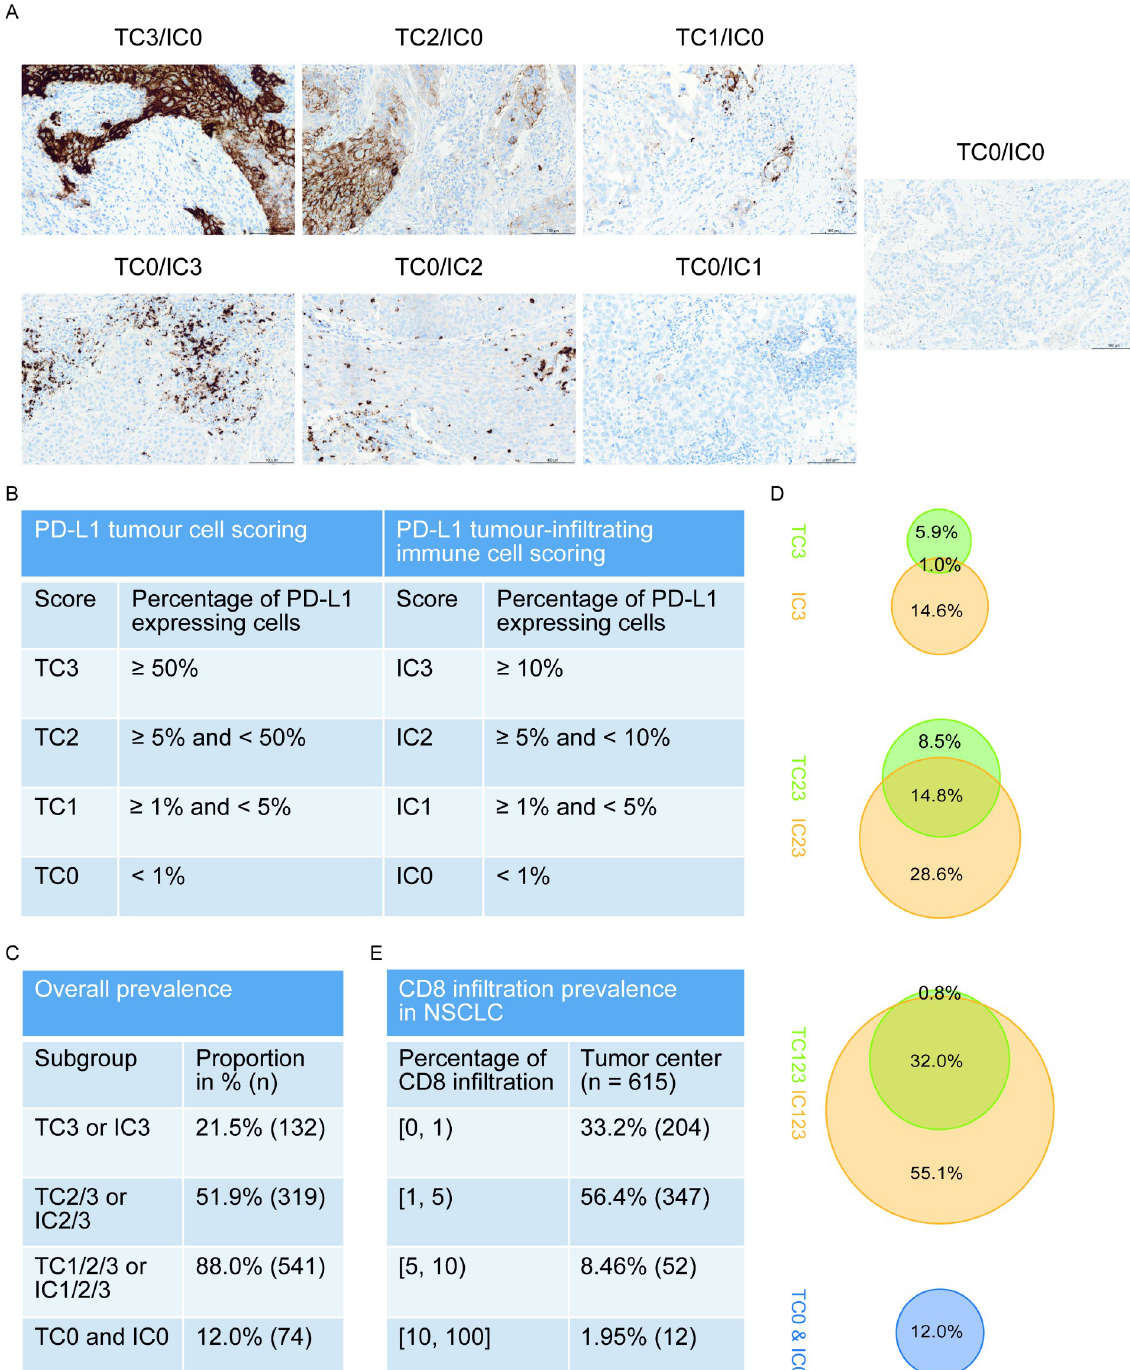
Fig 1. Examples of PD-L1 staining, scoring criteria, prevalence and overlap between PD-L1 expression on TC and IC and prevalence of CD8 infiltration in the tumor center in NSCLC. (A) PD-L1 expression by IHC on both TC and IC for each subgroup. (B) PD-L1 IHC scoring criteria on TC and IC (3) (C) Overall prevalence of overlapping PD-L1 subgroups. (D) Percentages in Venn diagrams represent the prevalence of PD-L1 expression by TC and IC in overlapping subgroups. (E) Overall prevalence of CD8 infiltration in the tumor center.